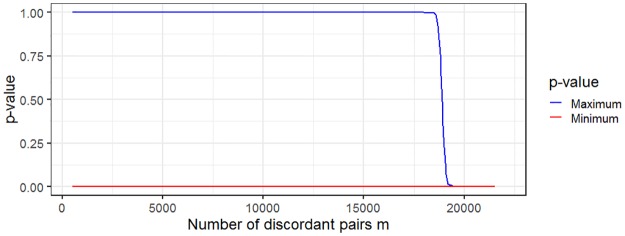
The range of p-value achievable for different number of discordant pairs m.The p-values were calculated using the test statistics presented in Table 3. The red line represents minimum possible p-value (corresponding to Λ(a)max) and the blue line represents the maximum possible p-value (corresponding to Λ(a)min).